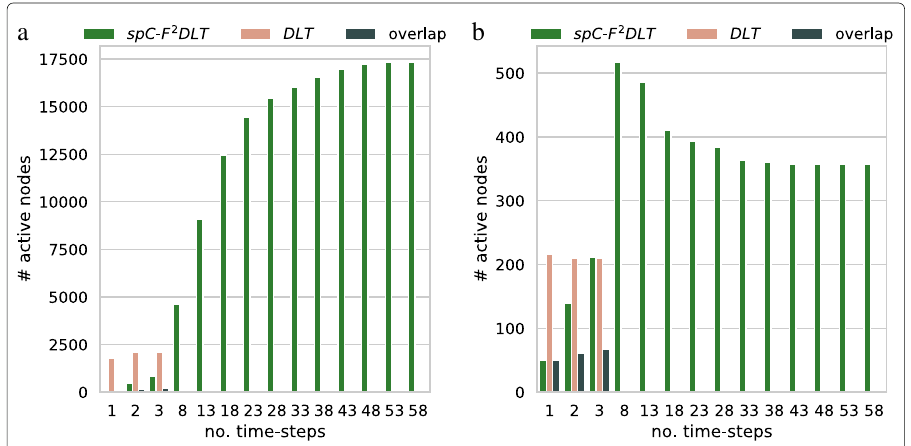
Fig. 16 spC - F 2 DLT vs. DLT: spread trends and overlaps, over time up to convergence of spC - F 2 DLT , on Slashdot. a I-Sources. b Stress-Triads